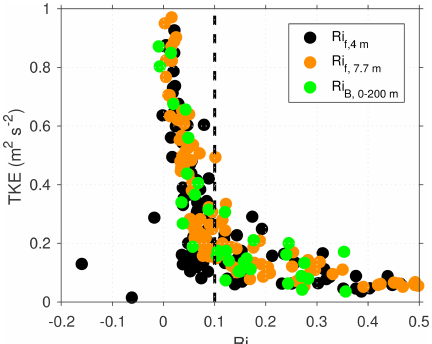
Figure 11. Relationship between turbulent kinetic energy, TKE, and Richardson number, Ri , for the cloud-free time periods be- tween 18:30 and 06:00UTC during all IOPs. TKE is always mea- sured at 4ma.g.l., while flux-Richardson numbers are measured at 4ma.g.l., Ri f , 4m , and 7.7ma.g.l., Ri f , 7 . 7m , and bulk-Richardson numbers are calculated between the surface and 200ma.g.l. using radiosonde data, Ri B , 0 − 200m